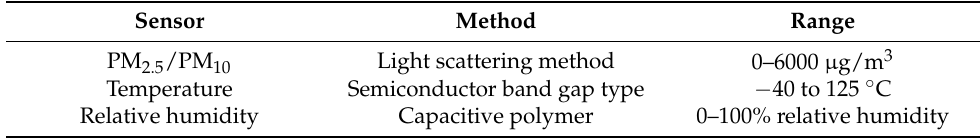
Table 1. Sensor specifications for indoor air quality stations.